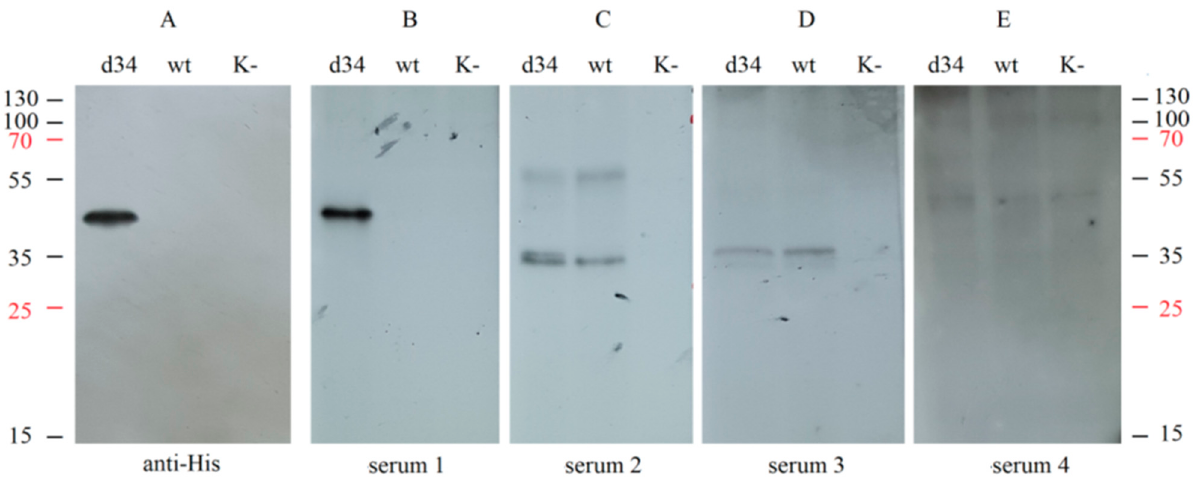
Figure 4. Analysis of the interaction of the d34 antigen with blood sera using Western blotting. HEK293FT cells were infected with MVA (wt), recombinant MVA-d34 (d34), or mock (K − ). The d34 antigen was probed with ( A ) anti-6x-His Tag antibodies (anti-His); ( B ) dengue fever-positive human sera (serum 1); ( C ) human sera from a TBEV-vaccinated individual (serum 2); ( D ) human sera from a TBEV- and YFV-vaccinated individual (serum 3); and ( E ) human sera from a YFV-vaccinated individual (serum 4). The numbers on the sides correspond to the protein molecular weight marker (M-PageRuler™ Plus Prestained Protein marker). K cells, HEK. The weight of the d34 protein is 48.3 kDa.